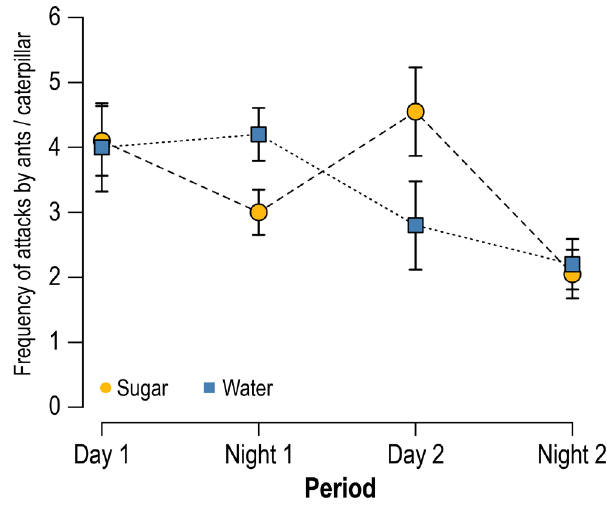
Fig 3 . Variation on the frequency of attacks by ants on each dummy caterpillar (Mean 3.36 ± 2.49 marks per caterpillar on each shrub) near artificial nectaries fixed on the branches of 40 individuals of the shrub Prosopis laevigata (Fabaceae) during day and night and under different food source quality treatments over a